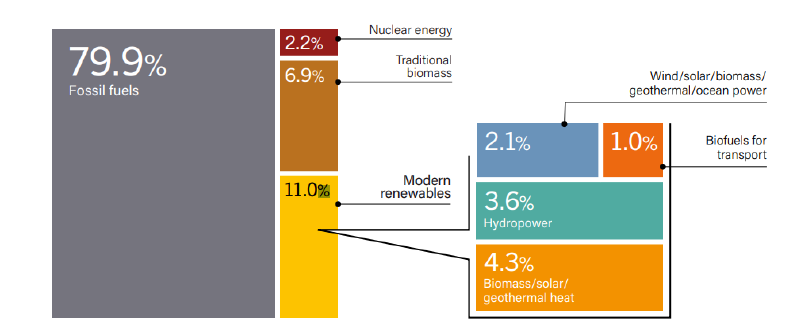
Fig. 1. – Estimated renewable share of total final energy consumption, 2018